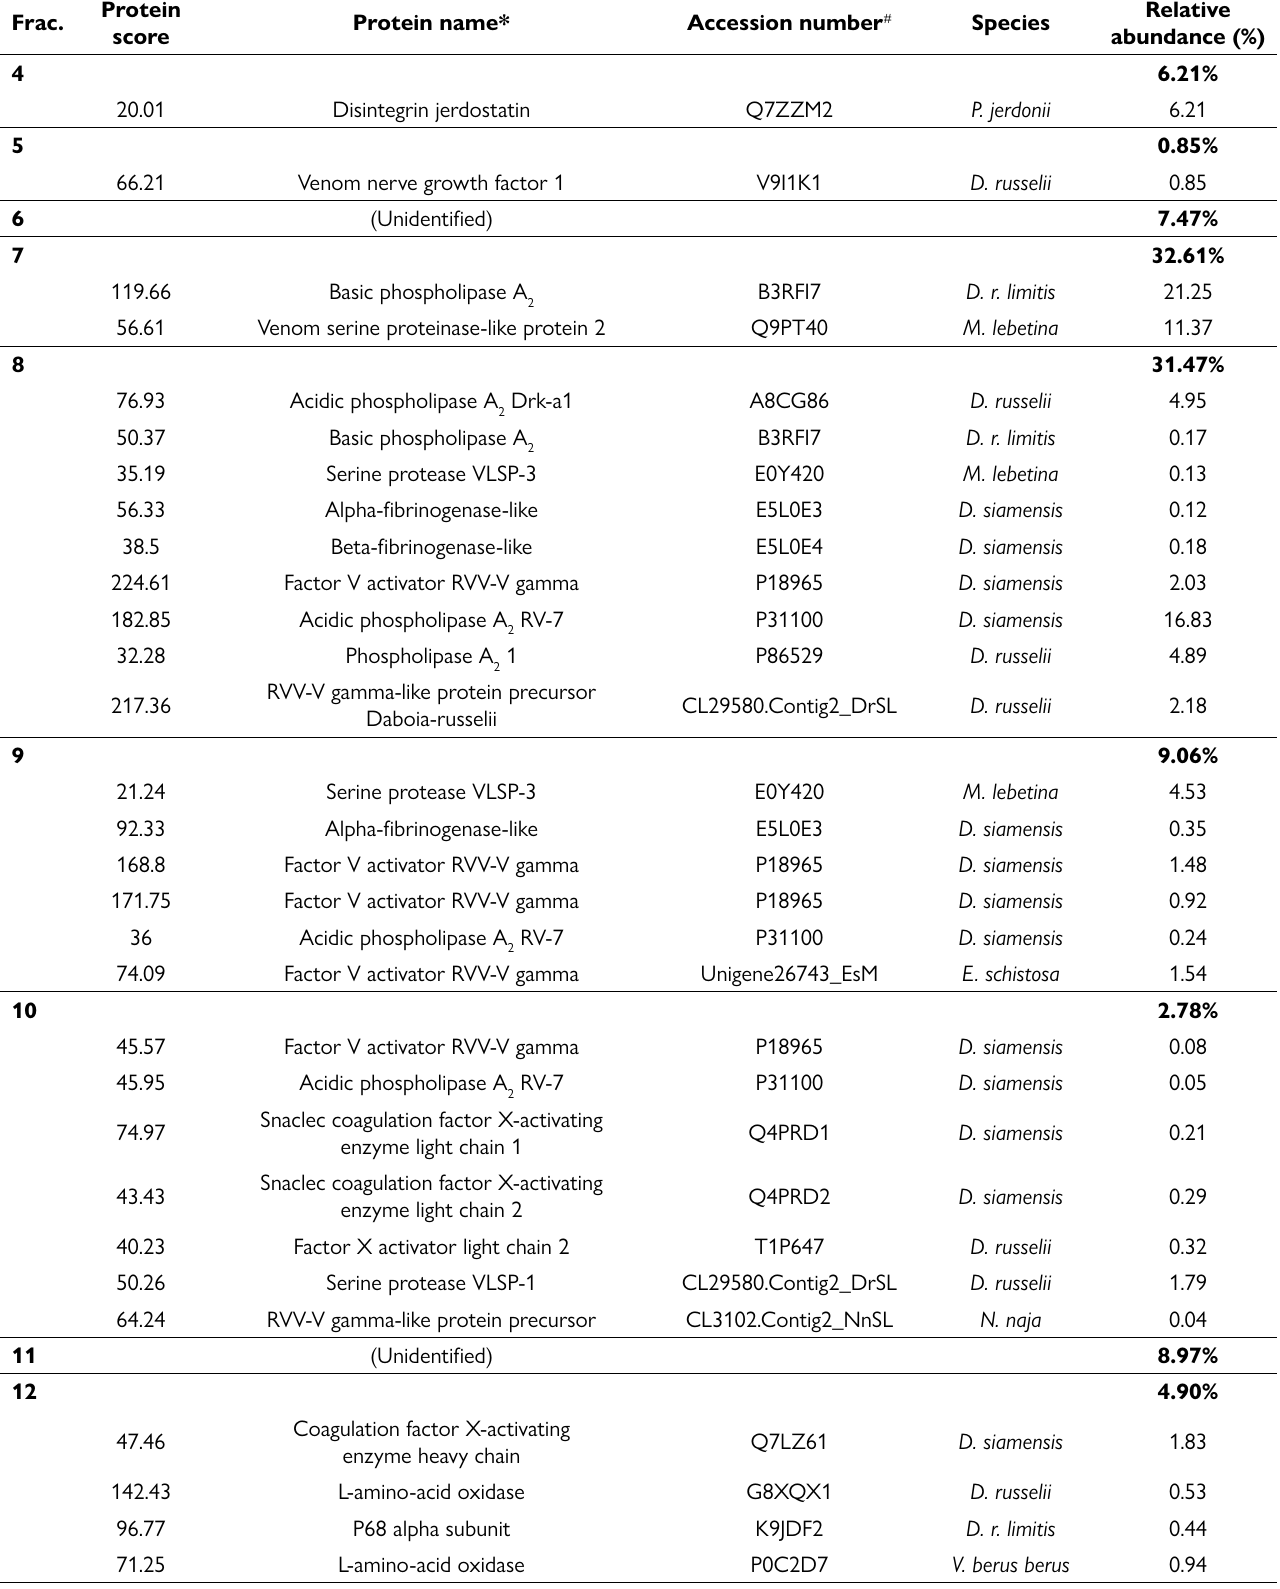
Table 2. Venom proteins of Daboia siamensis (Indonesia) assigned by fractions of reverse-phase HPLC. Data derived from LC-MS/MS analysis of the tryptic peptides